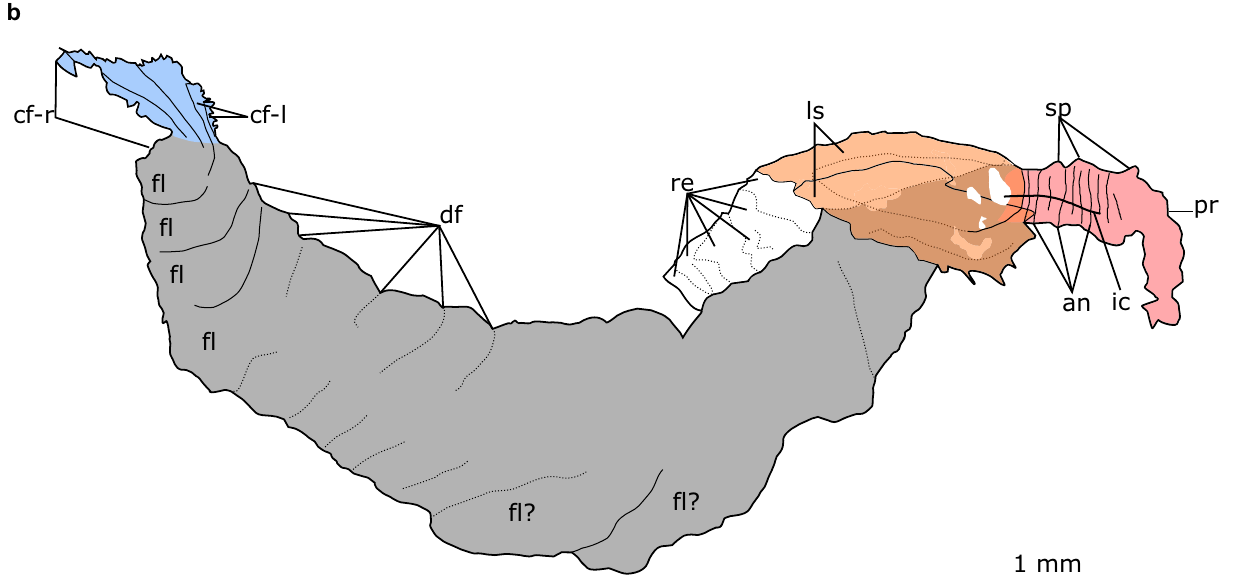
fan, cf-r right blades of caudal fan, df dorsal furrow in trunk, fl dorsolateral fl ap, ic internal canal of proboscis, ls lateral sclerite, pr proboscis, re subrectangular ele- ments posterior to lateral sclerites, sp spine on